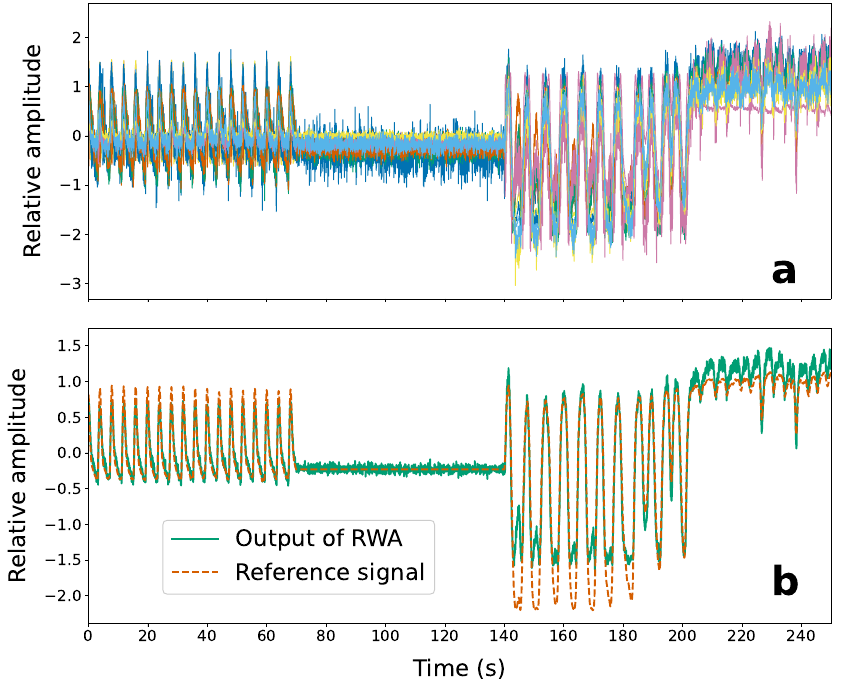
Figure 8. Recovered breathing signals from 11 target range bins before range-bin weighted averaging (RWA) ( a ), and after averaging ( b ) (solid green line). The reference breathing signal from the respirator motion phantom is also shown with the averaged signal (dashed orange